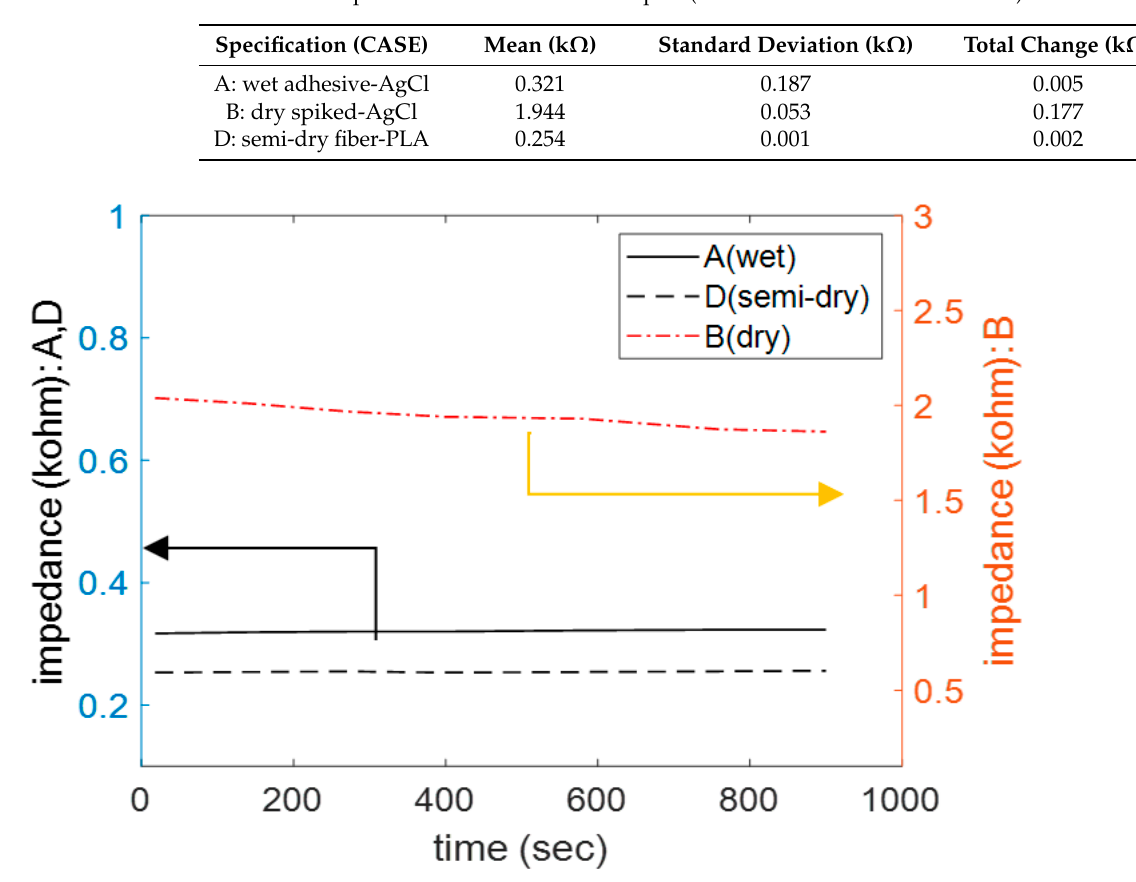
Figure 3. The impedance drifts of the test samples (15-min measurements at 50 kHz).